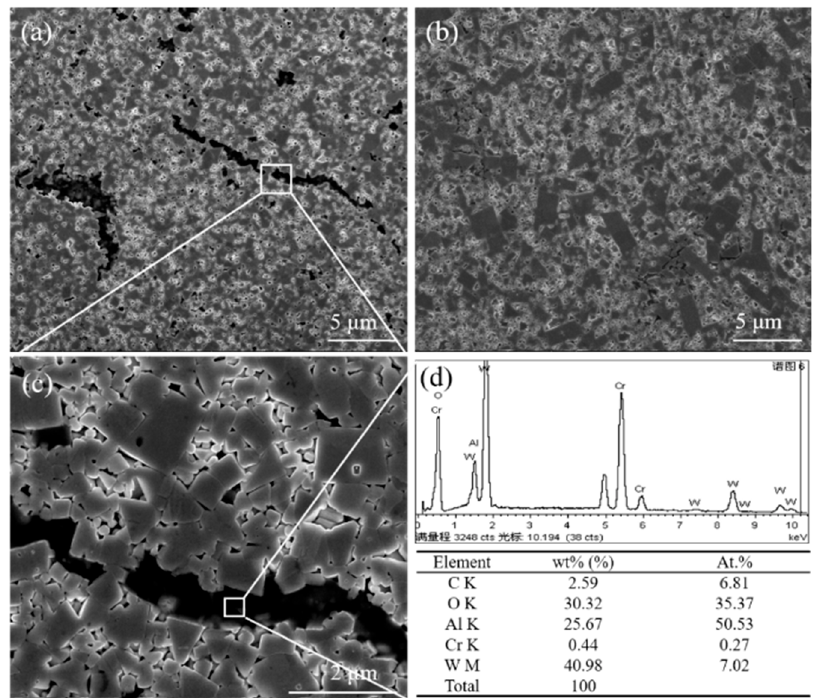
Figure 2. Microstructure of WC-10Ni 3 Al bulk materials using different ball-milling suspensions, ( a ) CH 3 CH 2 OH, ( b ) C 6 H 12 , ( c ) the details from the box in ( a ), ( d ) X-ray spectroscopy (EDS) for the black phase.